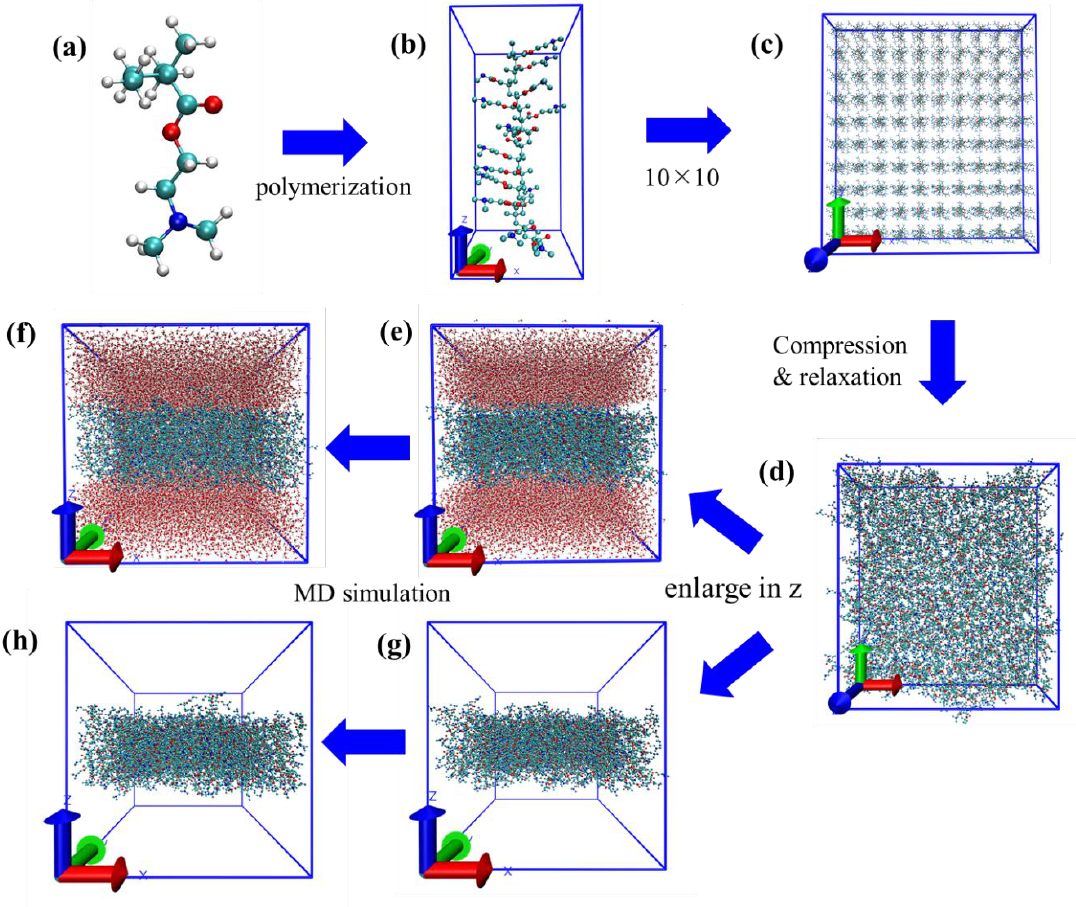
Figure 2. Modeling process and Simulation protocol of T4-DM system. ( a ) Repeat unit of DM; ( b ) single polymer chain of DM in simulation box (side view), ( c ) enlarged 10 times in x and y directions of ( b ) (top view); ( d ) compressed and relaxed configuration of DM membrane (top view); ( e ) initial configuration of DM with water system (side view); ( f ) final configuration of DM with water system (side view); ( g ) initial configuration of DM without water system (side view); ( h ) final configuration of DM without water system (side view).